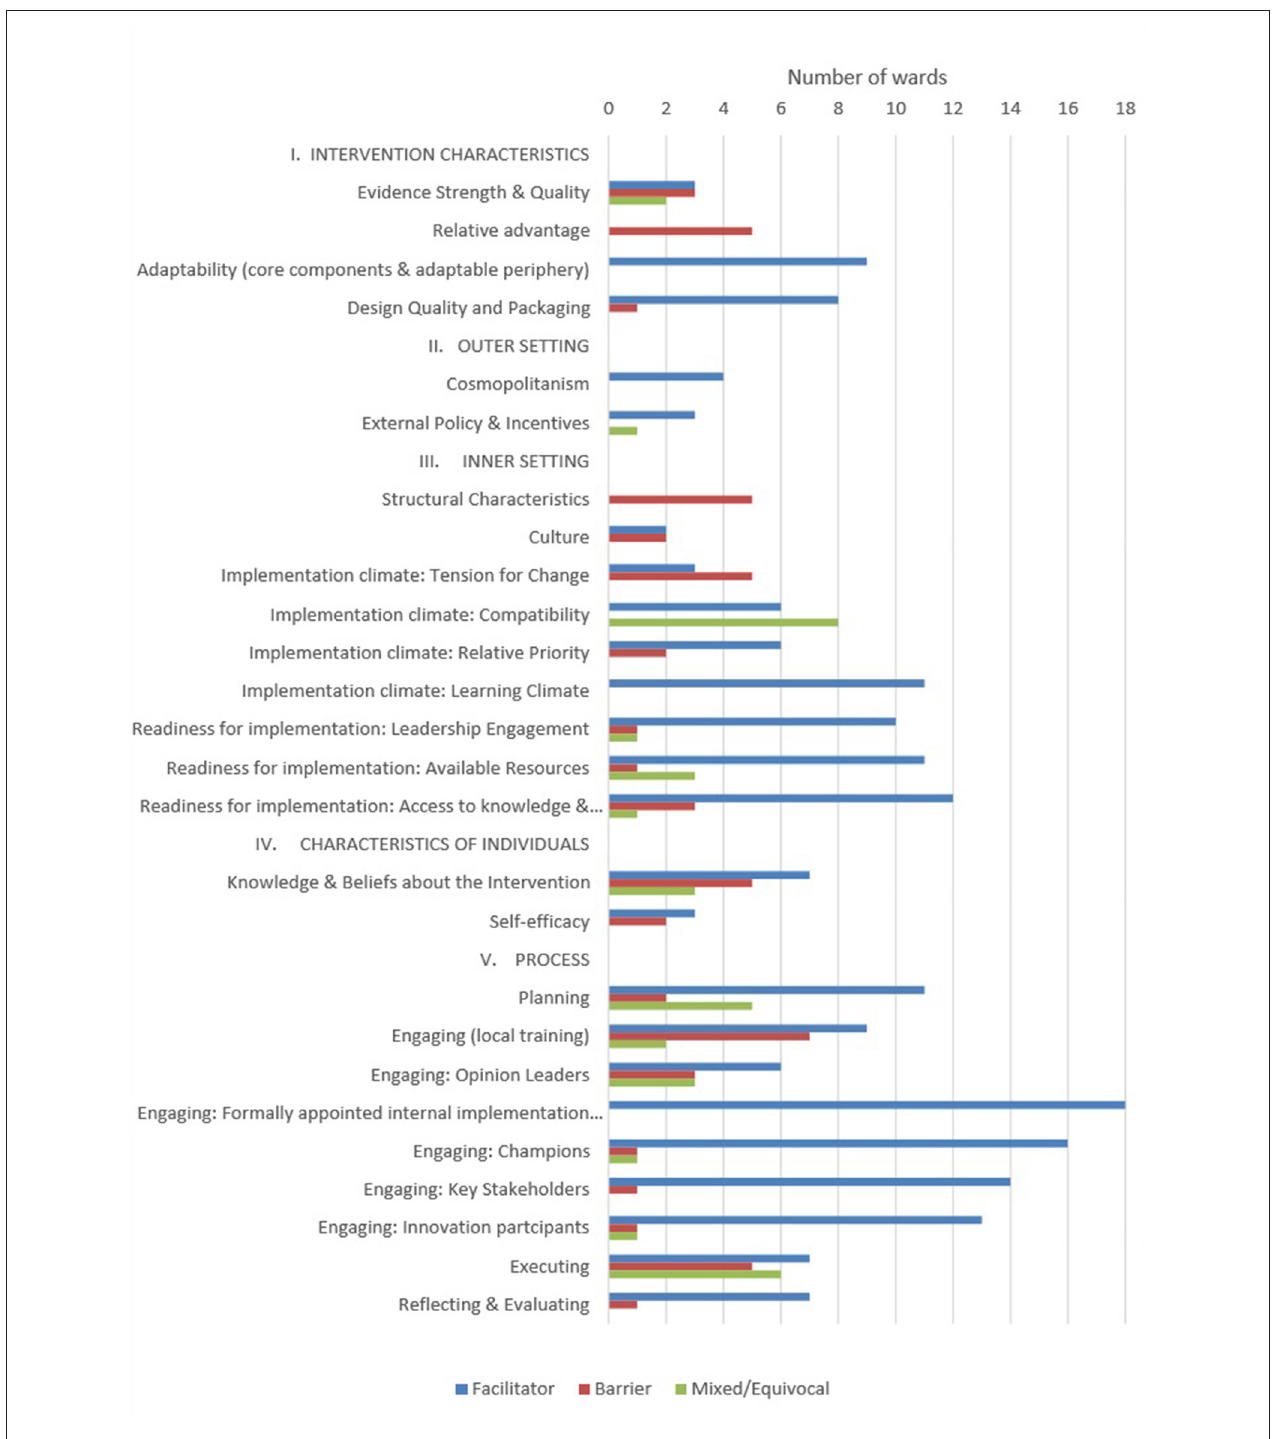
FIGURE 1 | Number of wards highlighting CFIR constructs as barriers or enablers to Safewards implementation.